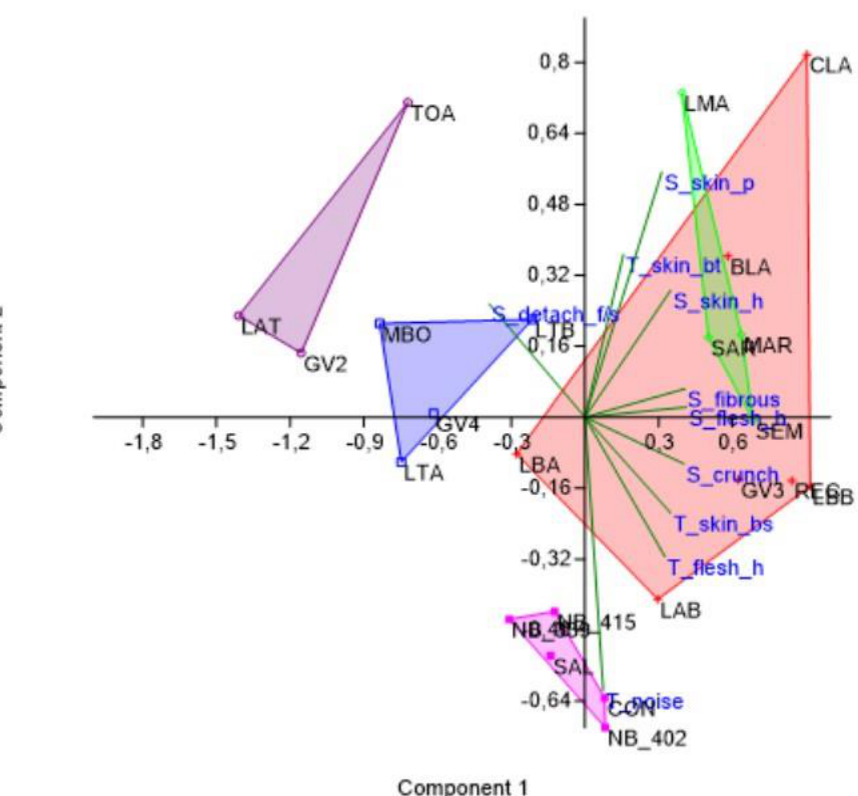
Figure 7. PCA on the entire data matrix. Legend: green, Itrana cv.; purple, black Itrana cv.; blue, Taggiasca cv.; lilac, Nocellara del Belice cv.; red, Bella di Cerignola cv.